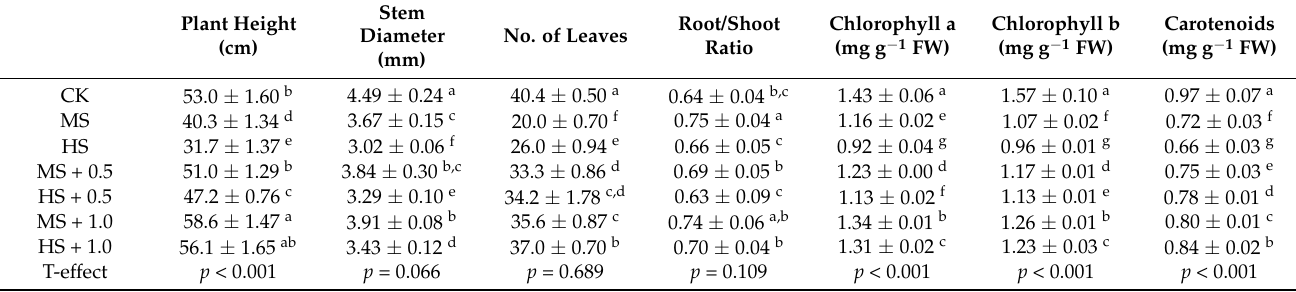
Table 1. Effect of soil water deficit and soil water deficit + foliar application of SA on plant height, stem diameter, number of leaves, root:shoot ratio, chl a, b and carotenoid contents in M. alba saplings. The small letters represent significant differences between the treatment means (T-effect) at p <